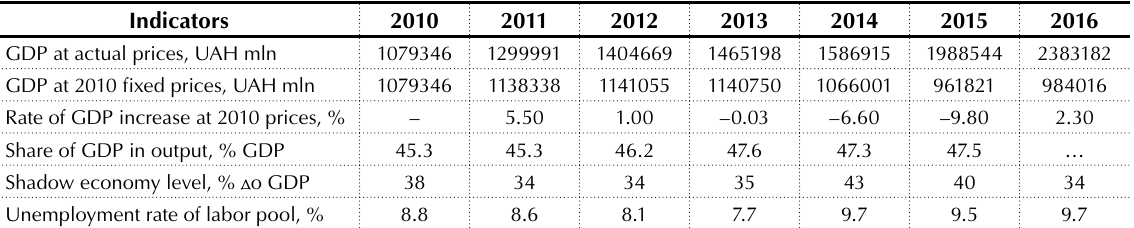
Table 2. Main macroeconomic indicators of Ukraine’s development Source: Національні рахунки України за 2015 рік [Natsionalni rakhunky Ukrainy za 2015 rik], Населення України, 2015 рік [Naselennia Ukrainy, 2015 rik], Квартальна оцінка валового внутрішнього продукту України за 2010–2016 роки [Kvartalna otsinka valovoho vnutrishnioho produktu Ukrainy za